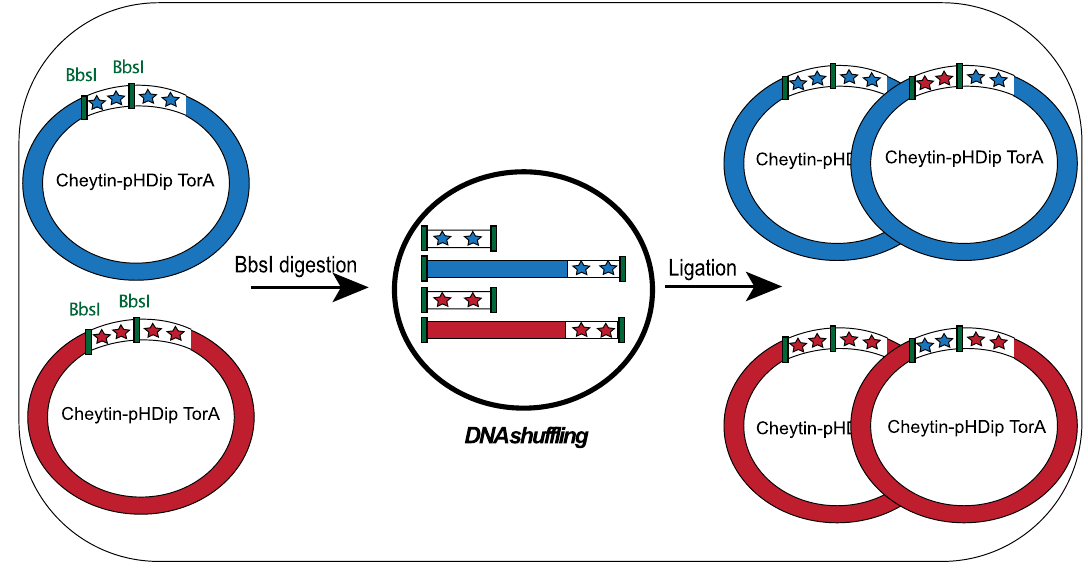
Figure 4. Schematic diagram of the DNA sequence shuffling process for two different Cheytin clones: Example of two phagemids from the library (clone 1 in blue and clone 2 in red). The four diversified loops windows are respectively represented in blue (phagemid 1) and red (phagemid 2) stars. BbsI restriction sites are represented by green lines. Cleavage of the phagemid by the enzyme BbsI makes it possible to split in two the gene